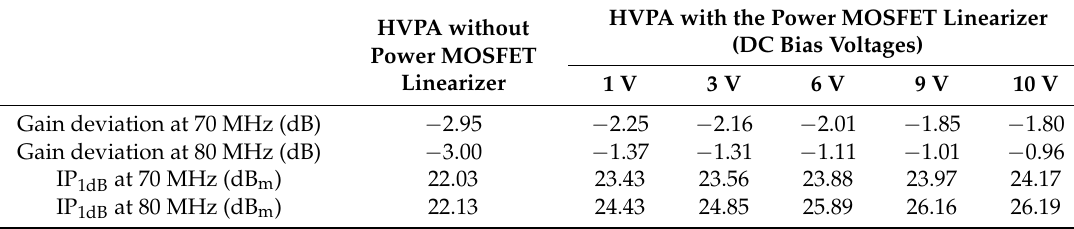
Table 1. Summary of the performances of the HVPA with and without the power MOSFET linearizer under various DC bias voltages. HVPA with the Power MOSFET Linearizer HVPA without (DC Bias Voltages) Power MOSFET Linearizer 1 V 3 V